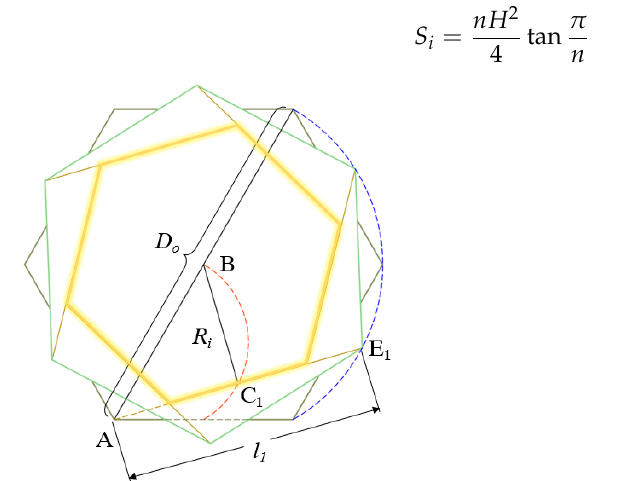
Figure 7. Top view of the half-folded state of the Kresling structure. The small dashed arc is the midpoint trajectory of the diagonal, and the big dashed arc is the endpoint trajectory of the diagonal. ( n =